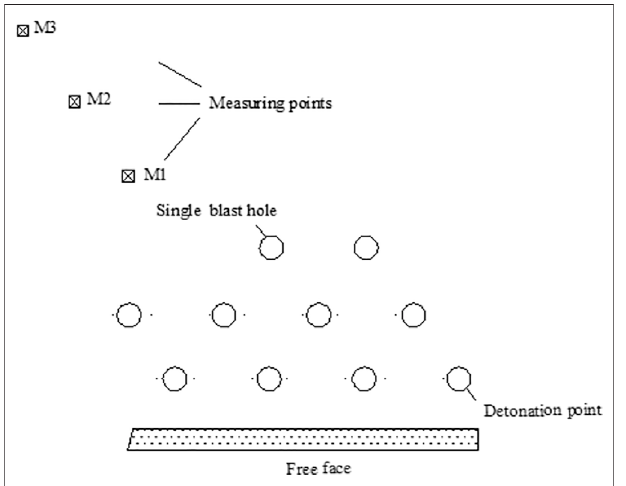
FIGURE 1 | Layout of boreholes and measuring points.